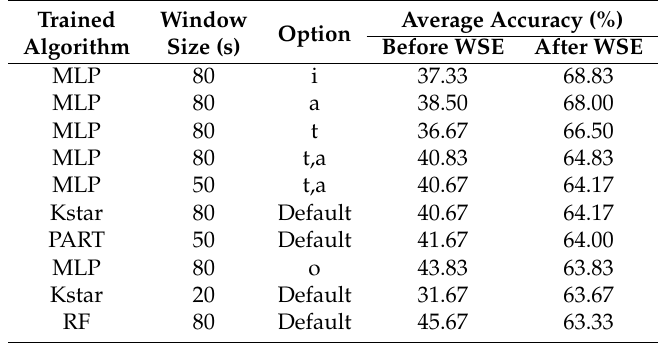
Table 7. Initial test results of CML algorithms (top ten